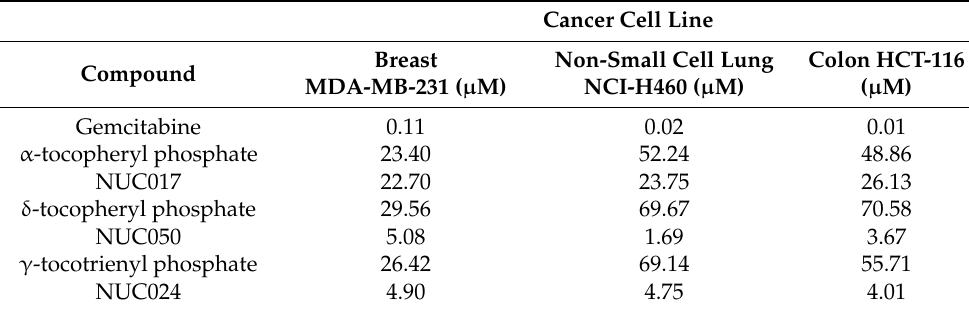
Table 1. Comparison of in vitro GI 50 between gemcitabine, VEP isoforms and VEP gemcitabine prodrugs NUC017, NUC050 and NUC024.